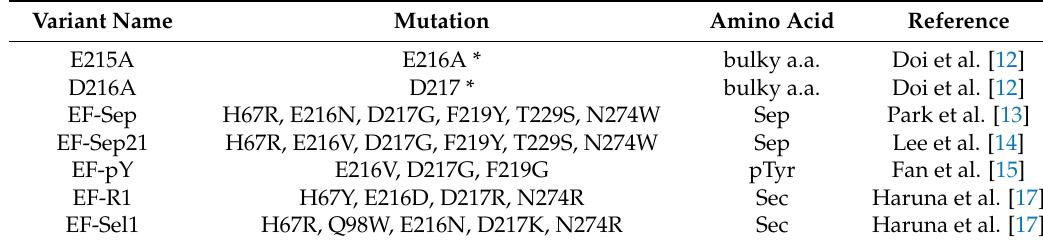
Table 1. List of engineered EF-Tu reported to date. Mutations introduced into EF-Tu and the amino acids tested for translation are shown. Note that the numbering of the amino acids of EF-Tu is derived from UniProtKB/Swiss-Prot: P0A6N3.2 (https://www.uniprot.org/uniprot/P0A6N3), and therefore some of the amino acid positions, indicated by asterisks, are different from the original